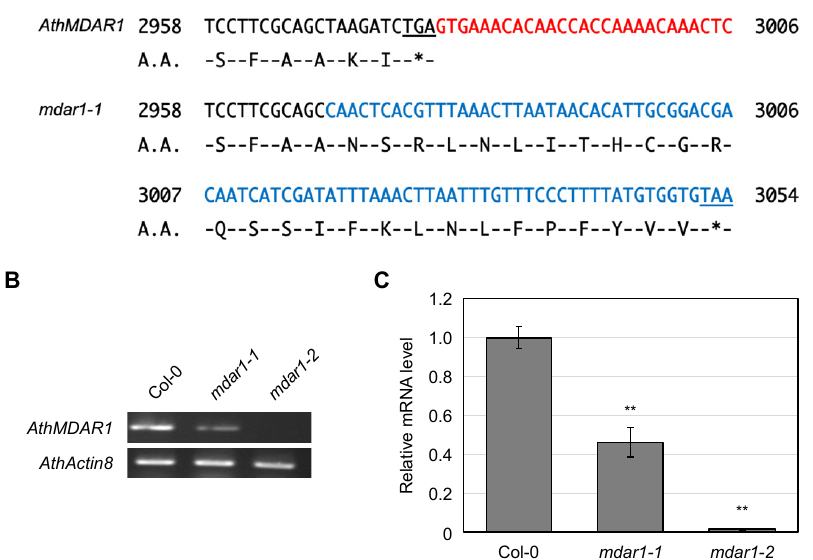
Figure 6. The mdar1-1 T-DNA insertion results in an in-frame insertion in the AthMDAR1 gene. ( A ) The DNA and amino acid sequences around the stop codon in the wild-type ( AthMDAR1 ) and T-DNA-inserted ( mdar1-1 ) genes are shown. The 3 ′ untranslated region and inserted sequence (derived from T-DNA) are shown in red and blue, respectively. The stop codons are underlined. The T-DNA insertion resulted in an 85-bp in-frame insertion with a new stop codon in the AthMDAR1 gene just before its original stop codon. ( B , C ) Arabidopsis thaliana wild-type (Col-0), mdar1-1 , and mdar1-2 plants were grown on half-strength MS medium containing 1% sucrose for 2 weeks. Shoots from these plants were used for the following reverse transcription (RT)-PCR analyses. ( B ) Semi-quantitative RT-PCR analysis for AthMDAR1 and AthActin8 (control). The reverse primer (for AthMDAR1) was designed to anneal to just before (upstream of) the T-DNA insertion in the mdar1-1 mutants. ( C ) Quantitative RT-PCR. The transcript levels of AthMDAR1 genes were analyzed. The value in the wild type was set to 1. Data are shown as the means ± SE of three biological replicates. Significant differences among genotypes (Tukey–Kramer test): ** p < 0.01 vs. the values of the wild-